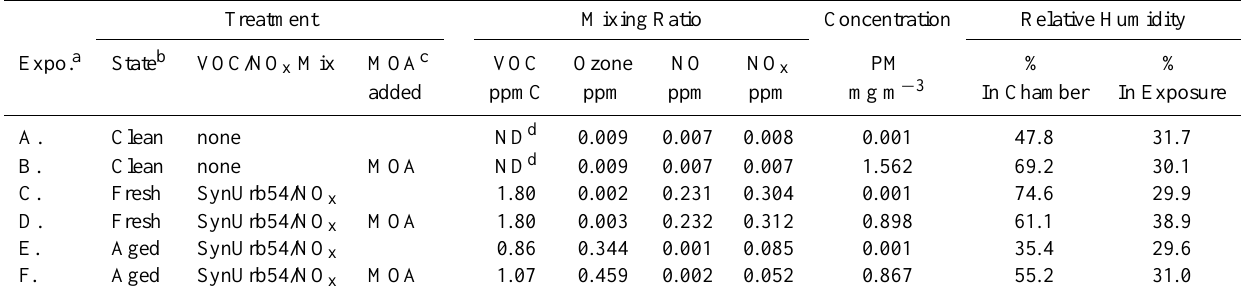
Table 3. Six Exposure Conditions During Blank and Complex Mixture